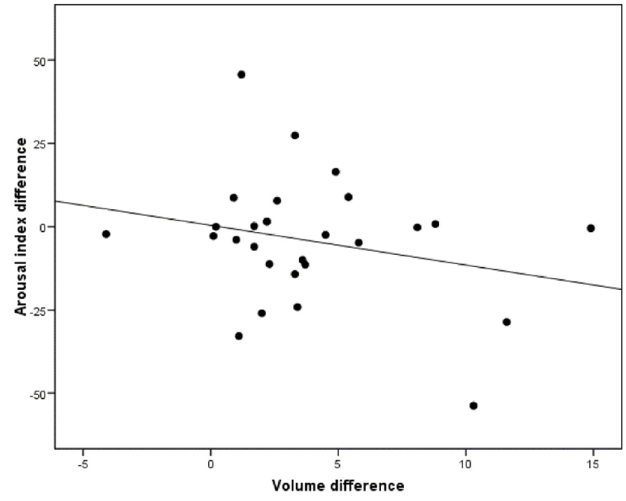
Figure 10. Correlation between the changes in arousal index after MAD titration and the volumetric changes of the upper airway according to the OSA severity ( p = 0.198).